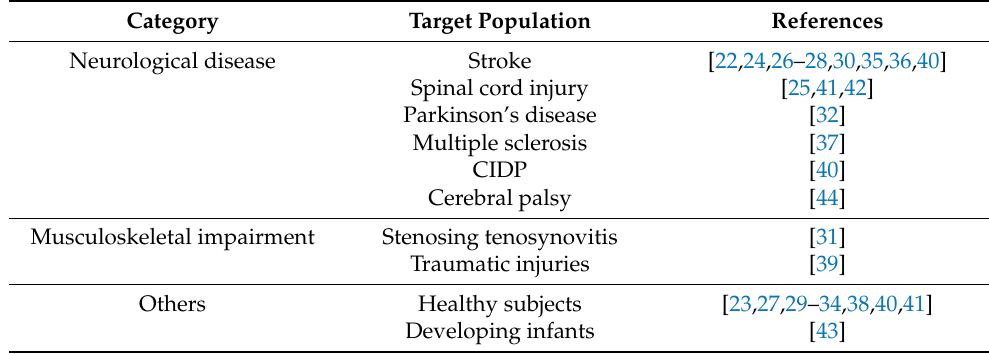
Table 3. Classification based on target population. CIDP = chronic inflammatory demyelinating polyneuropathy.